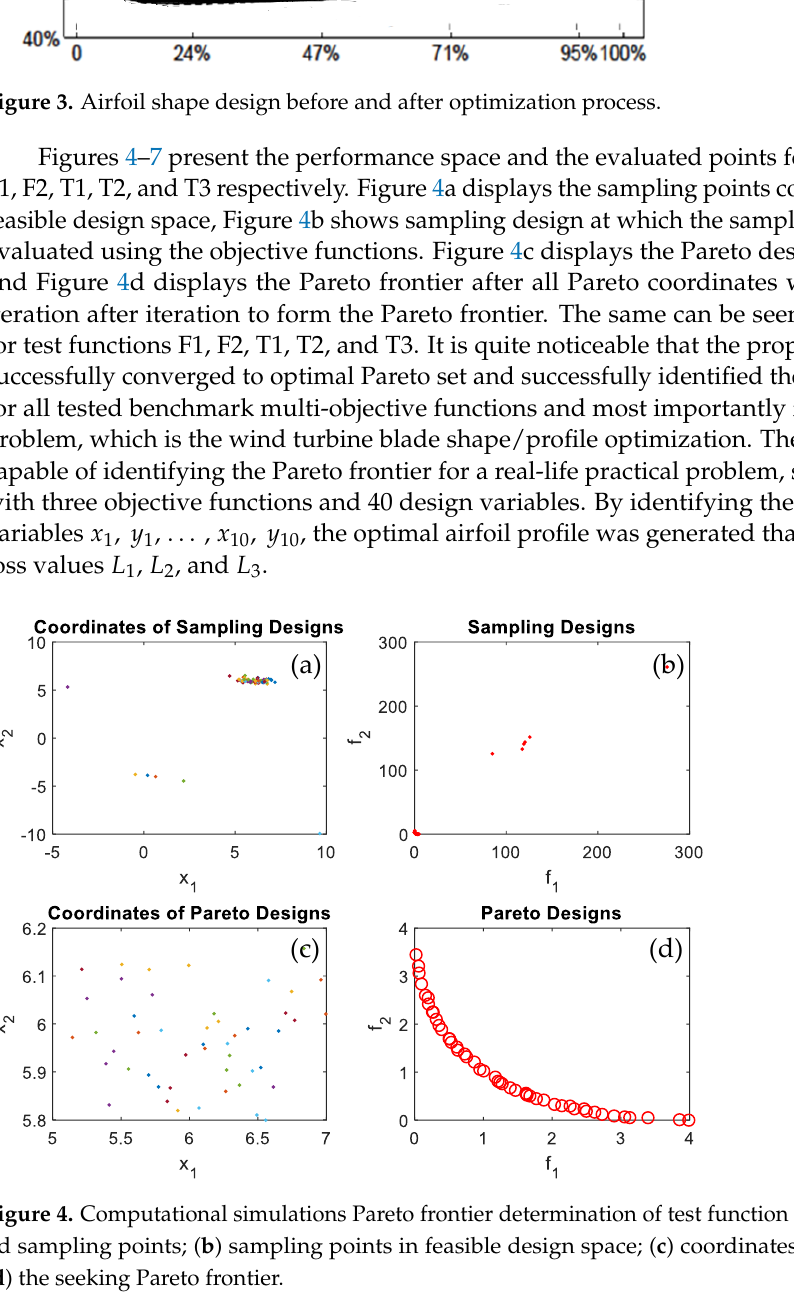
Figure 5. Computational simulations Pareto frontier determination of test function F2 ( a ) coordi- nates od sampling points; ( b ) sampling points in feasible design space; ( c ) coordinates of Pareto points; ( d ) the seeking Pareto frontier.